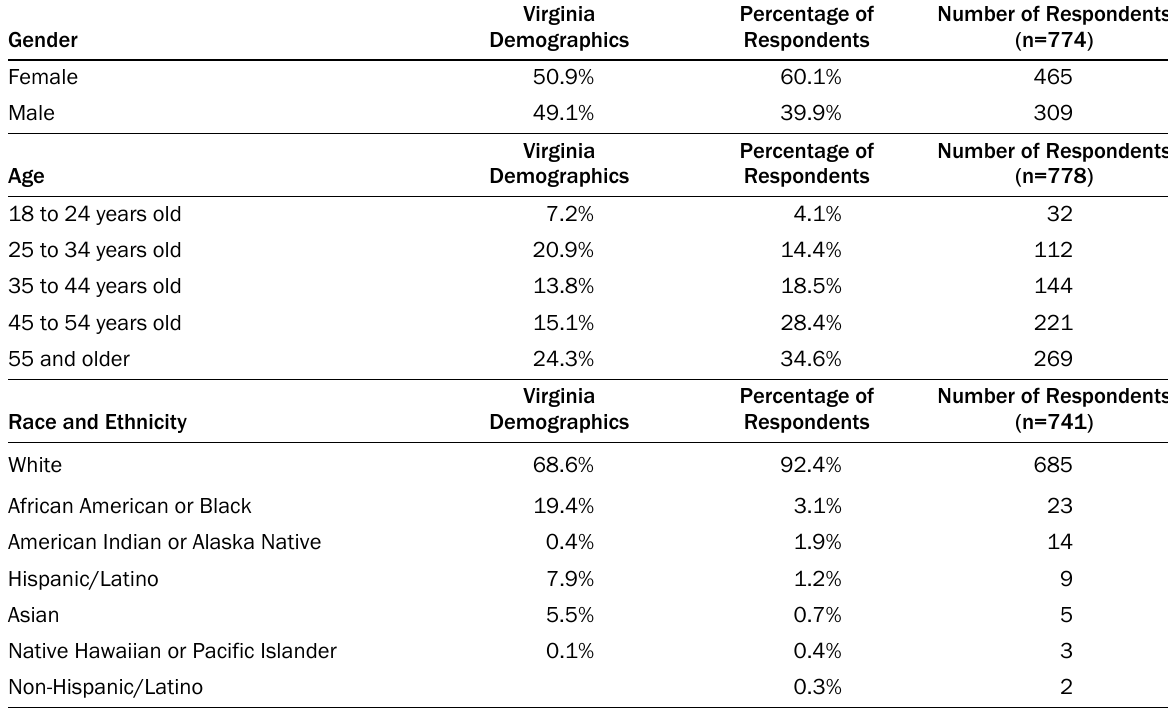
Table 2. Virginia Demographics Compared to Survey